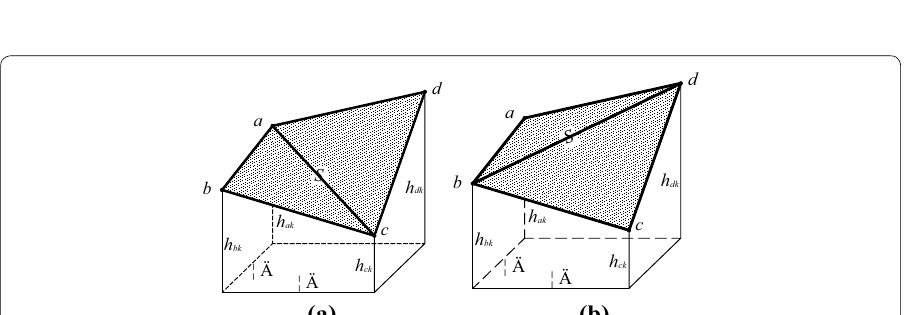
Fig. 1 The projective covering method